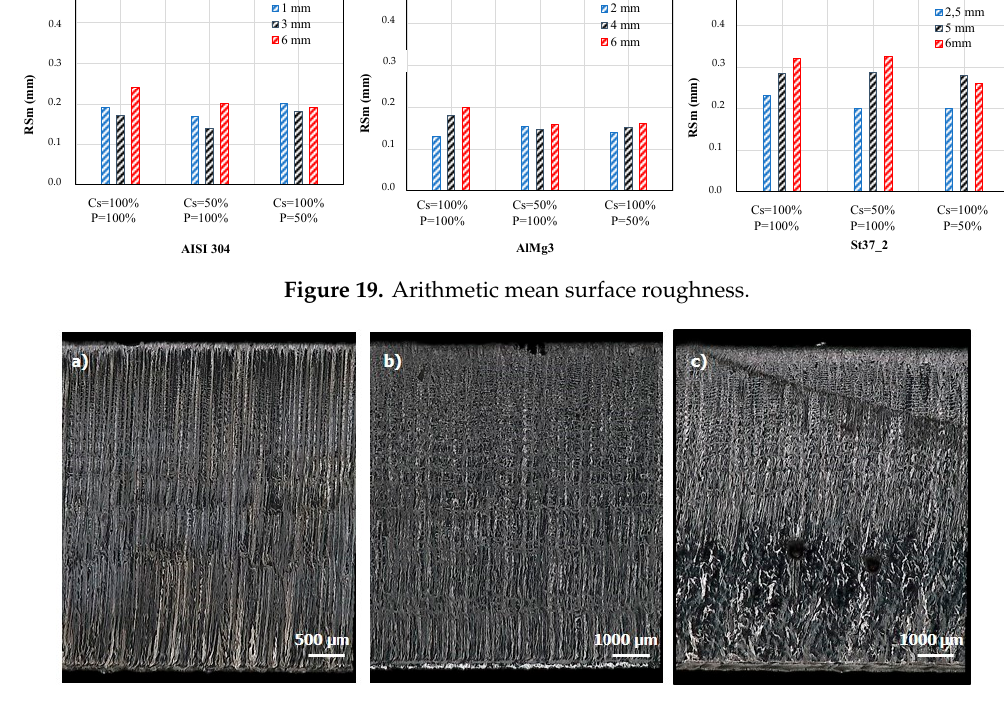
Figure 20. AISI 304 kerf lateral surface: ( a ) 6 mm, Cs = 50% P = 100%; ( b ) 3 mm, Cs = 50% P = 100%; ( c ) 3 mm, Cs = 100% P = 100%.